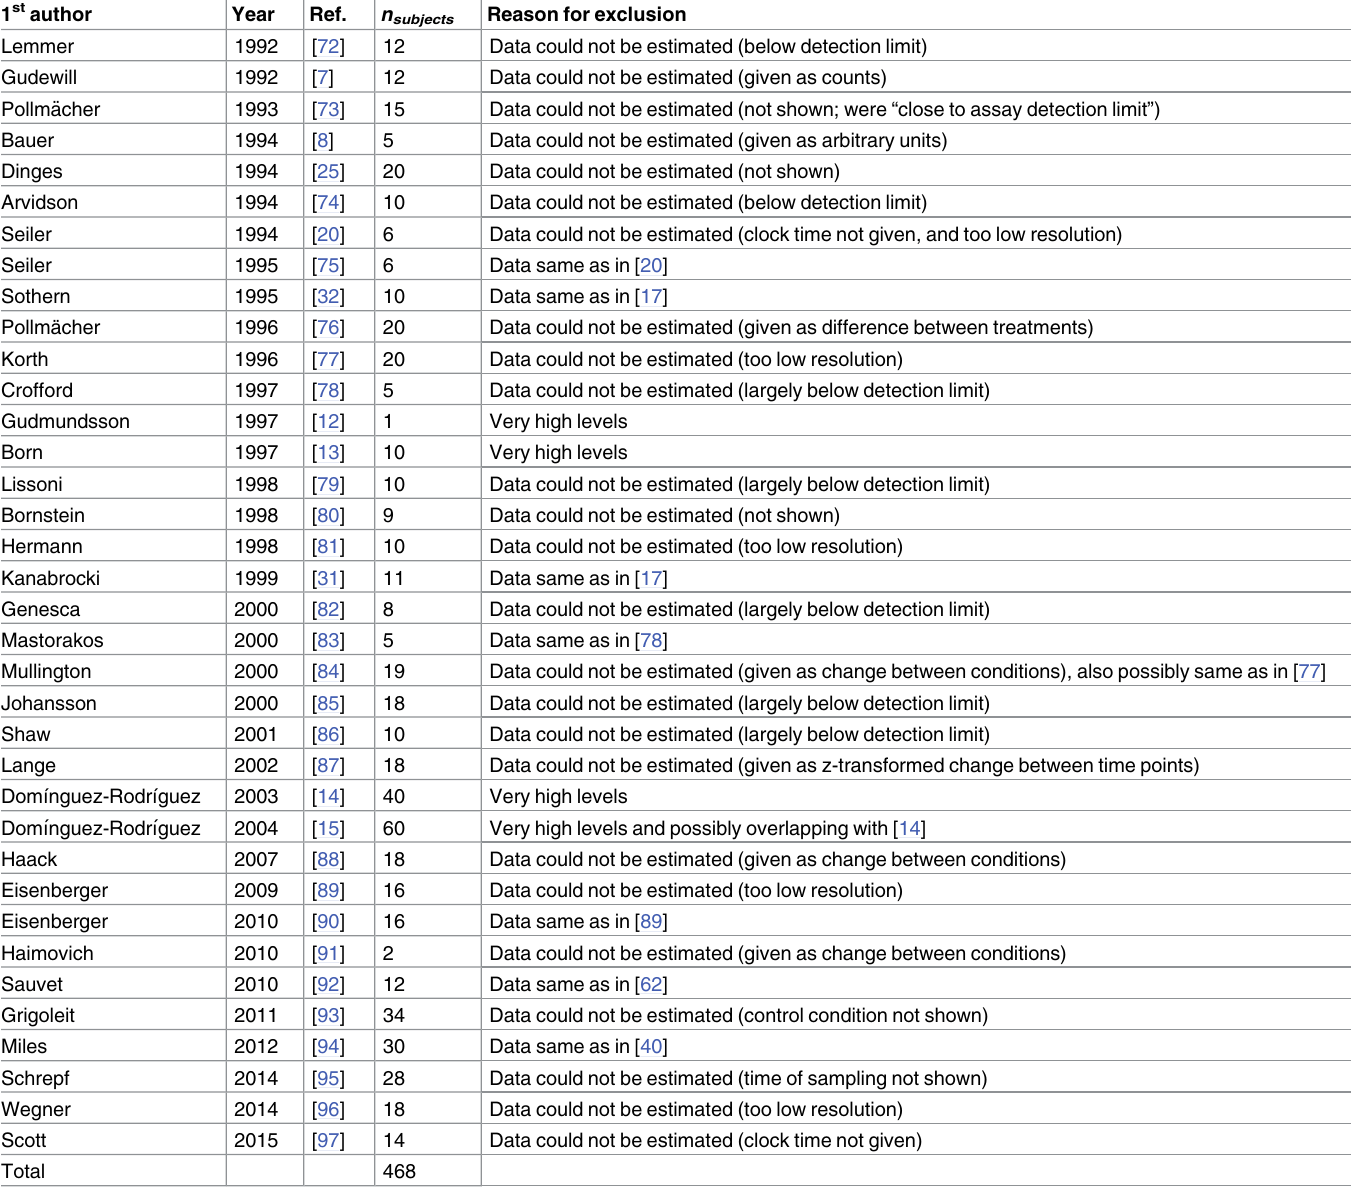
Table 2. Characteristics of excluded